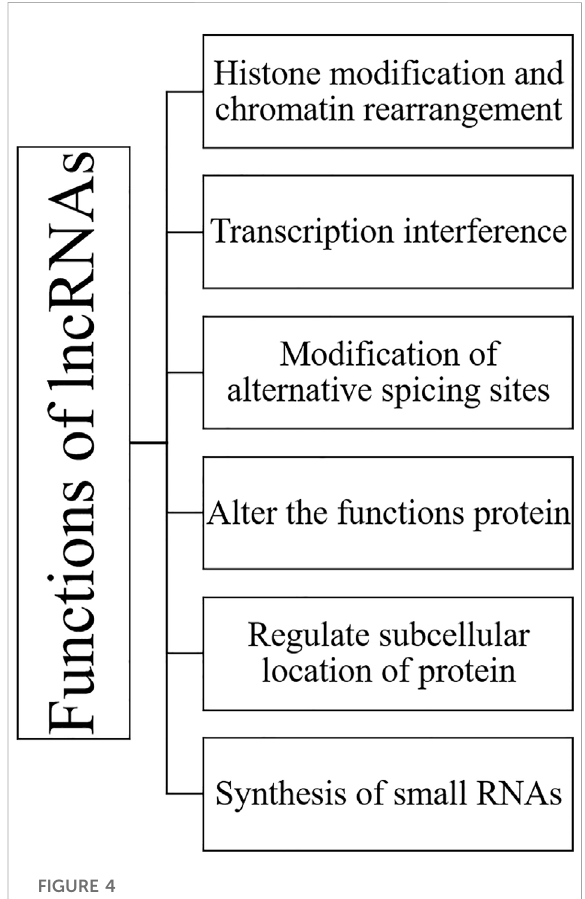
FIGURE 4 Showing different functions of long noncoding